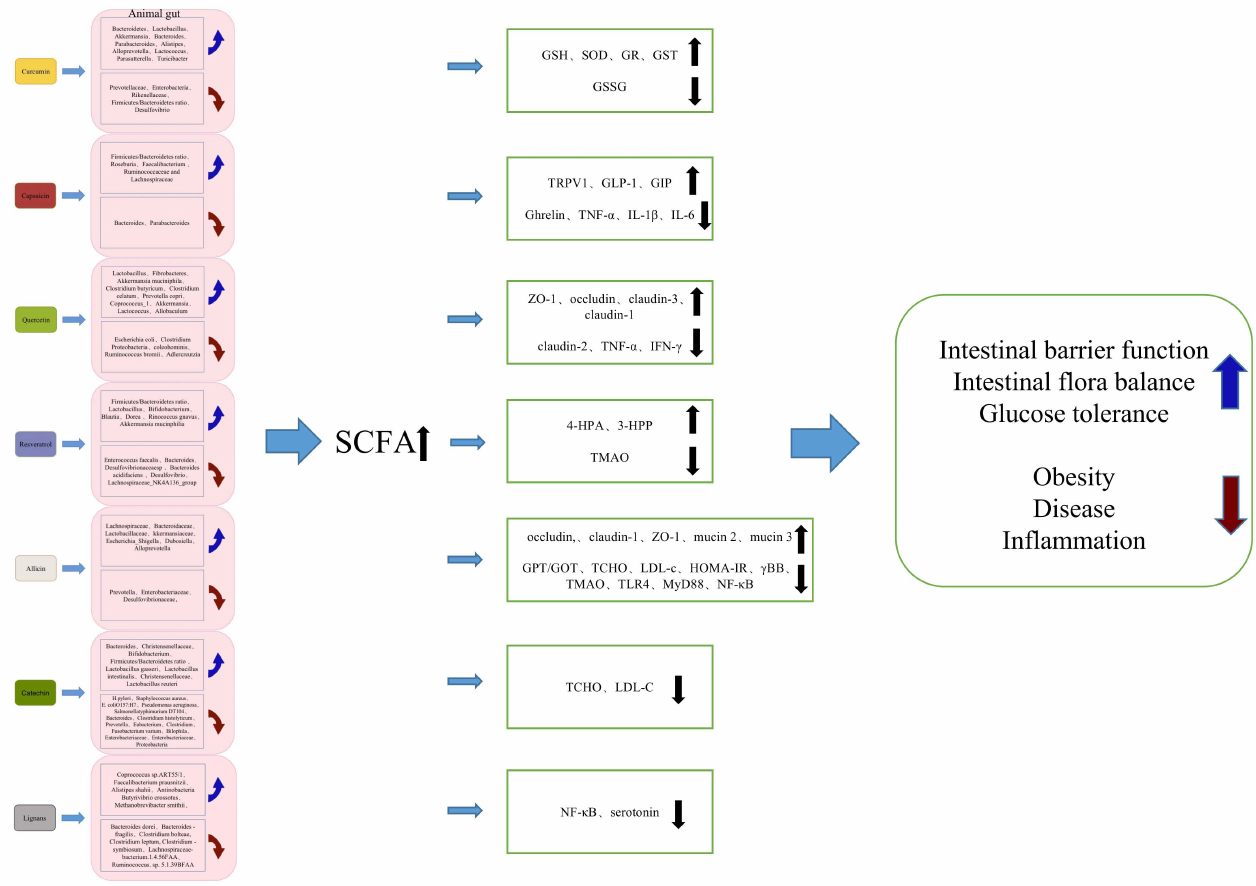
Figure 2. Functions of plant-derived bioactive compounds in metabolic disorders by regulating intestinal SCFA